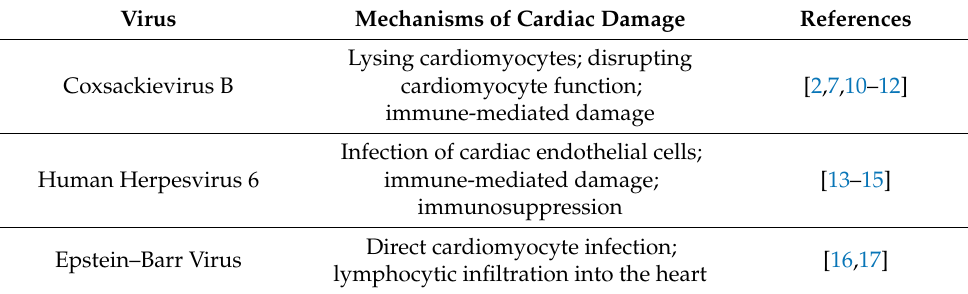
Table 1. Viruses known to induce cardiomyopathies and their mechanisms of action.